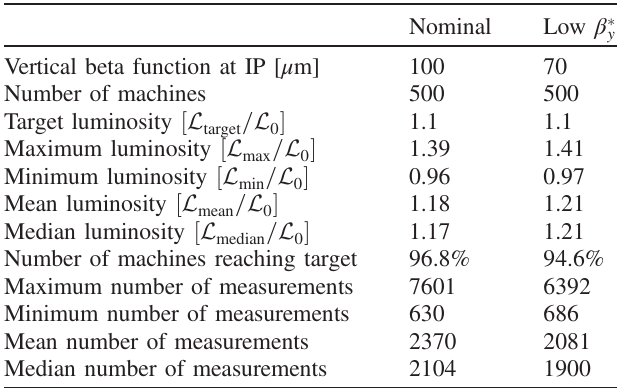
TABLE III. Results of the tuning studies of the nominal and the low- β (cid:2) y